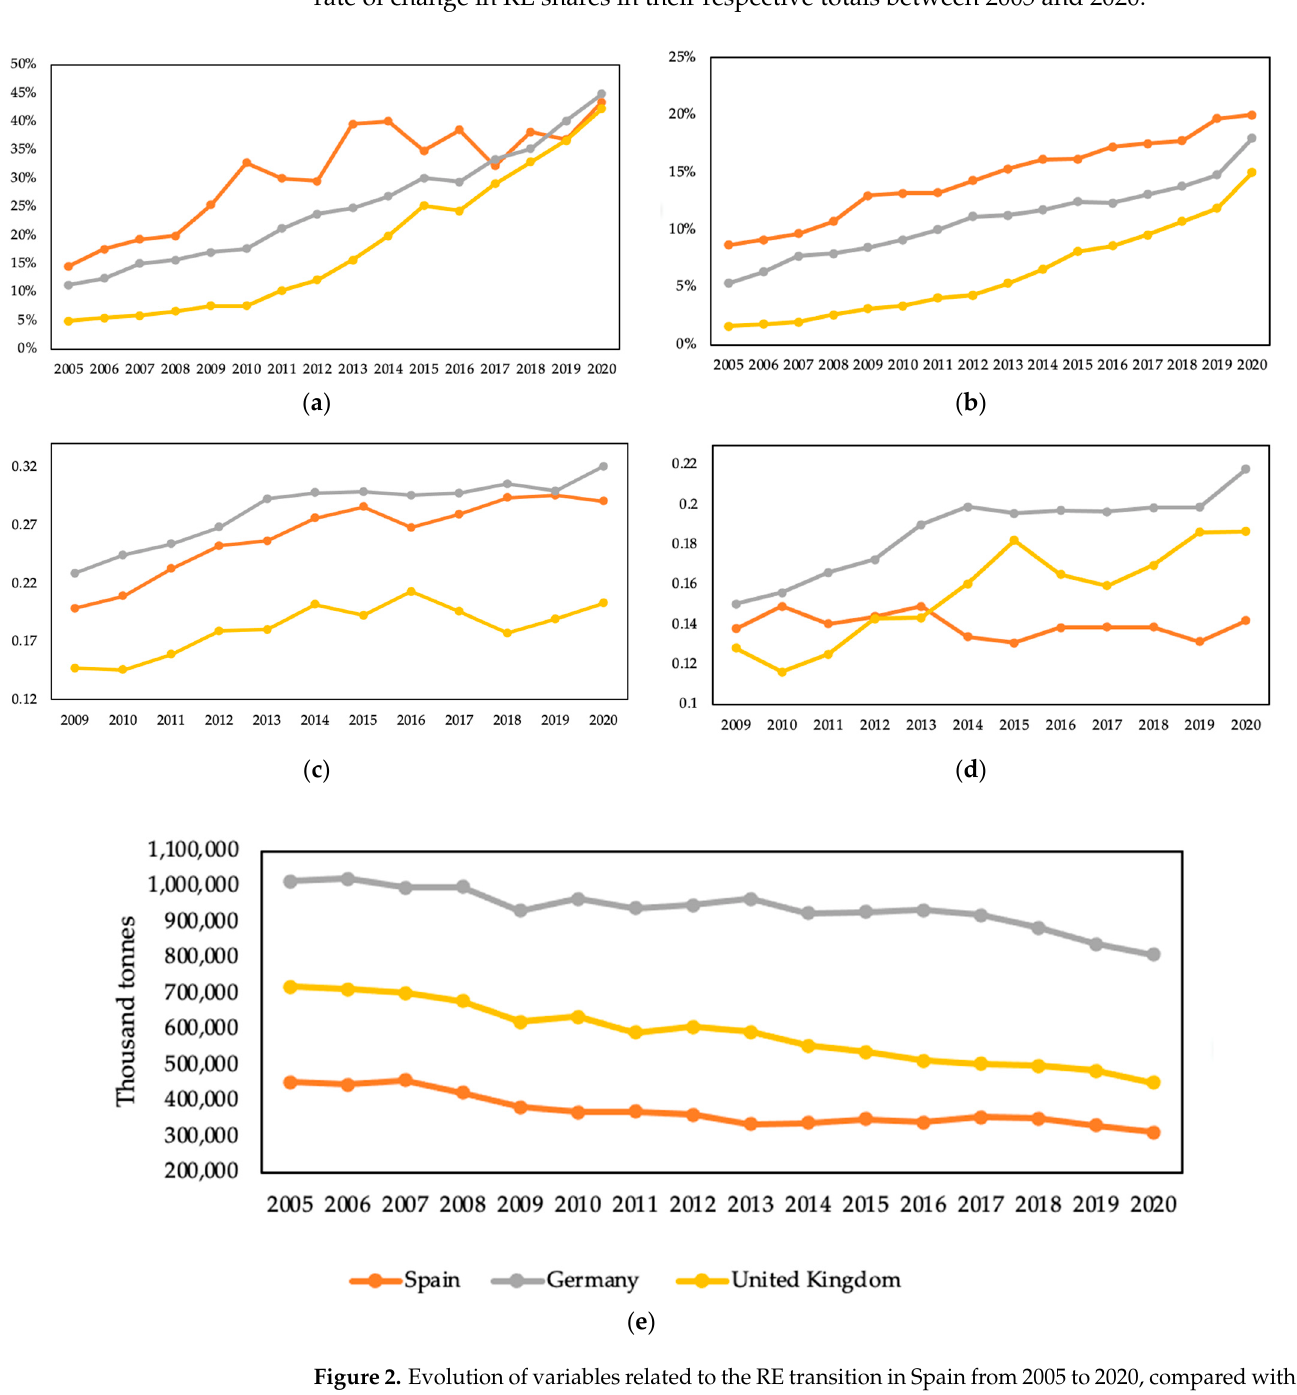
Figure 2. Evolution of variables related to the RE transition in Spain from 2005 to 2020, compared with Germany and the UK (source: adapted from [7] and own calculations based on Eurostat data [72]): ( a ) Share of RE in gross electricity production. ( b ) Share of RE in gross available energy. ( c ) Price of electricity for household (all taxes and levies included in constant prices of 2015 (EUR per kWh). ( d ) Price of electricity for the non-household consumer (all taxes and levies included in constant prices of 2015 (EUR per kWh). ( e ) GHG emissions, 1990–2018.